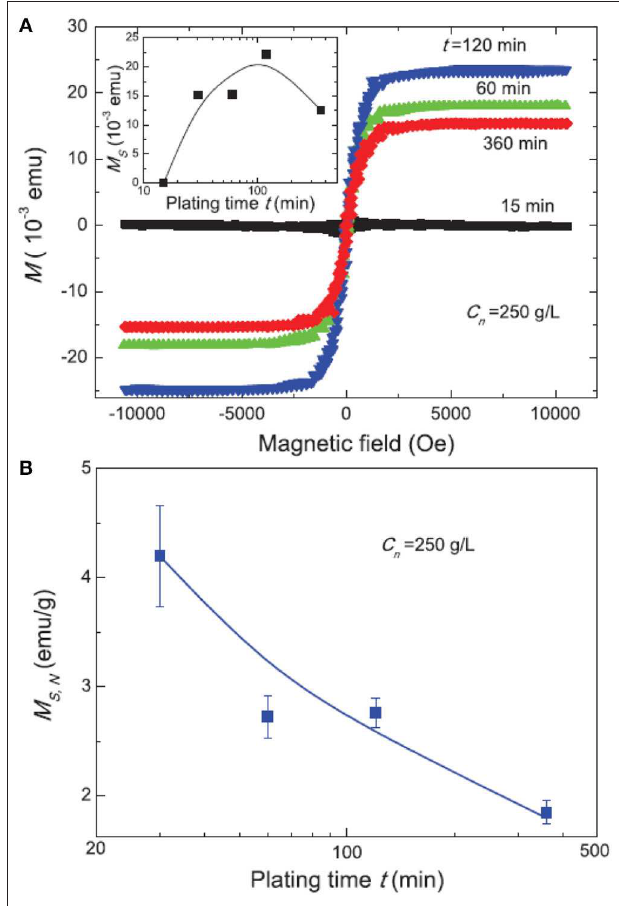
FIGURE 10 | Field dependent magnetization curves of Ni/Psi in dependence on the deposition time (A) and normalized saturation magnetization in dependence on the deposition time (B) . The inset in (A) shows the saturated magnetization vs. time. Reproduced from Nakamura et al. [61], with permission of AIP